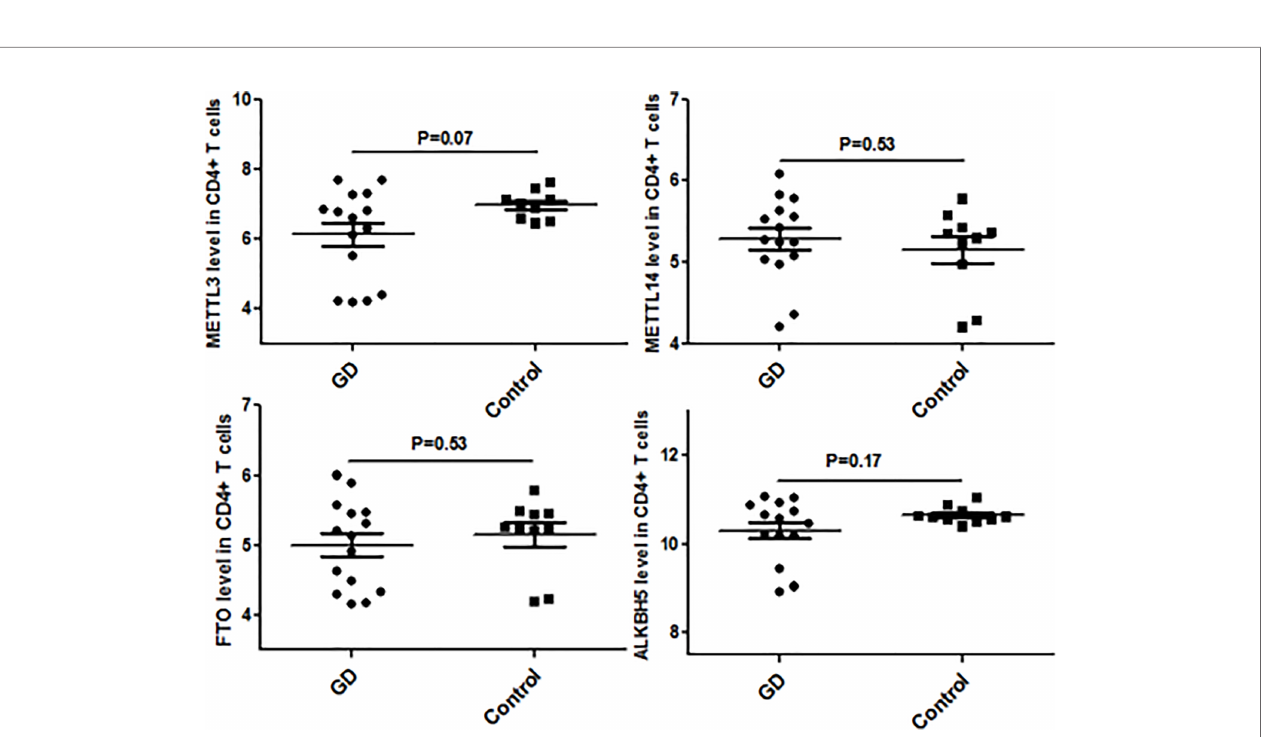
FIGURE 4 | mRNA modi fi cation key enzymes ’ expressions in CD4+T cells of